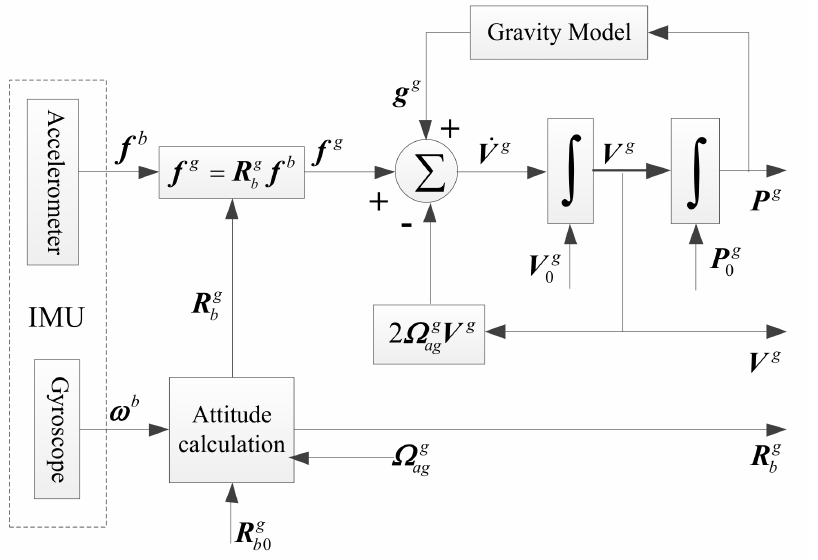
Figure 1. Mechanization of strapdown inertial navigation in the LCEF